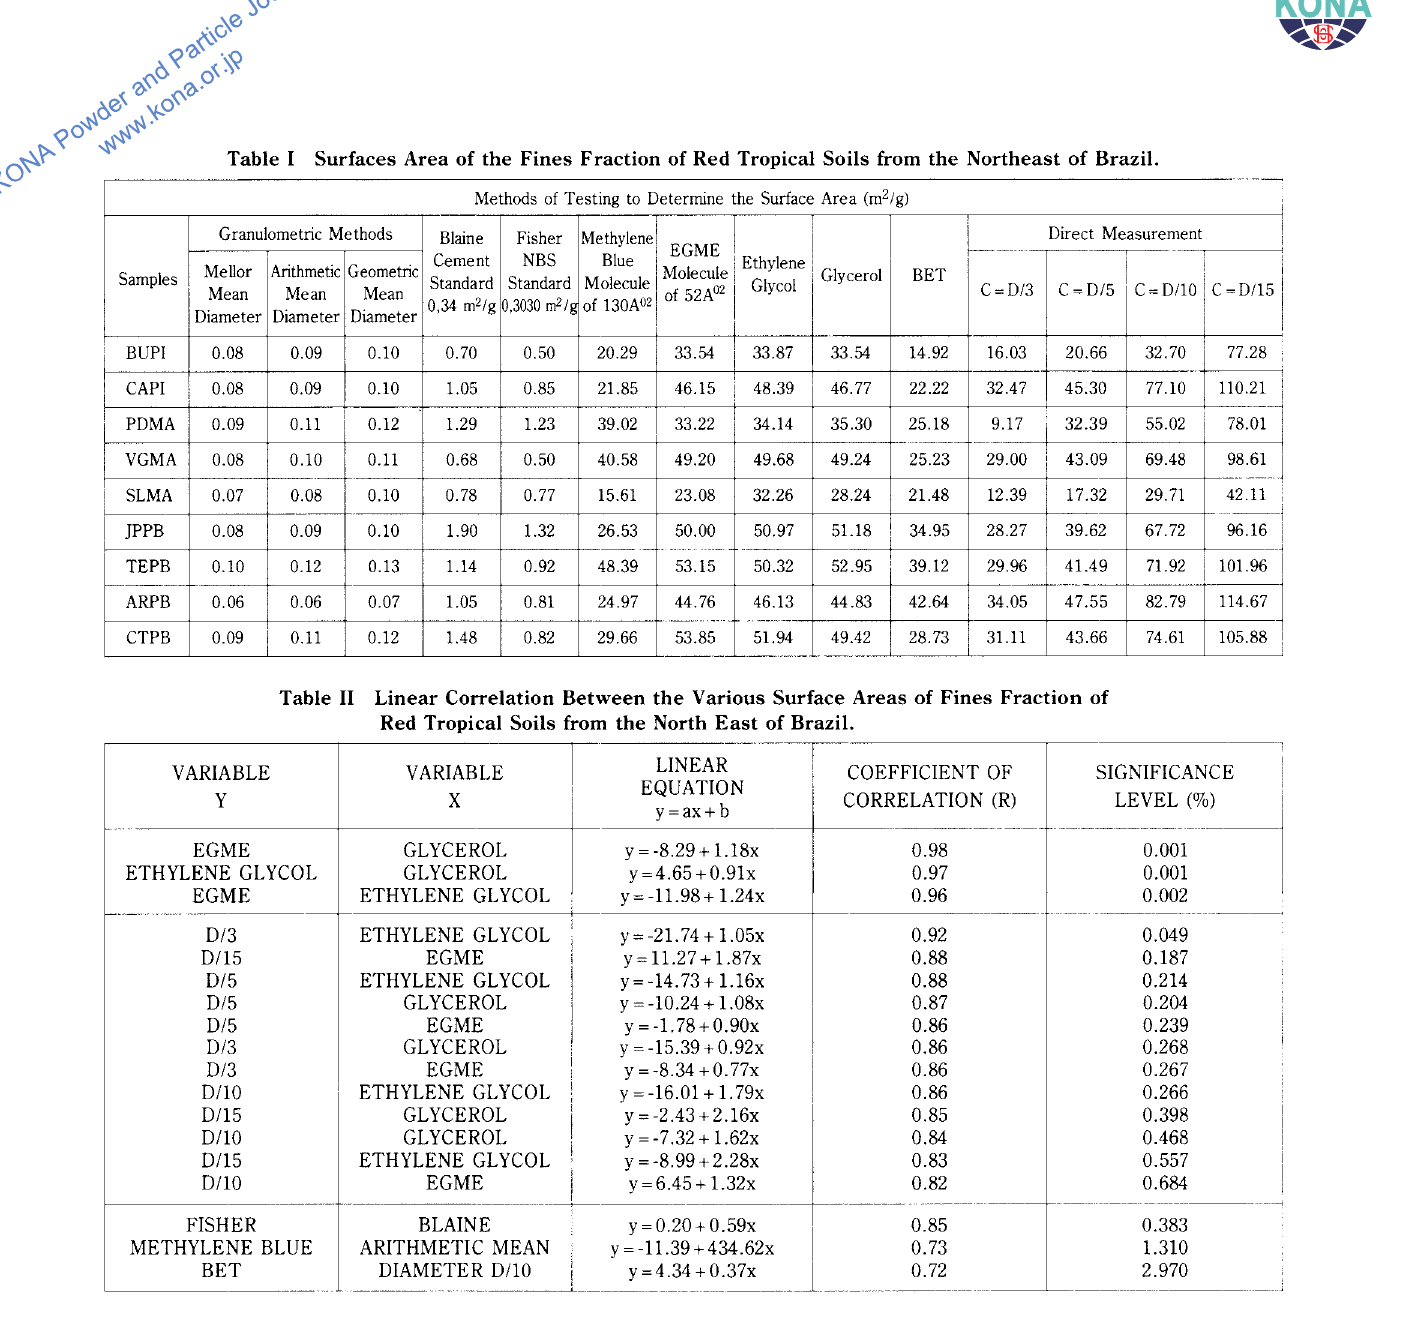
Table I Surfaces Area of the Fines Fraction of Red Tropical Soils from the Northeast of Brazil. Methods of Testing to Determine the Surface Area (m2/g) Granulometric